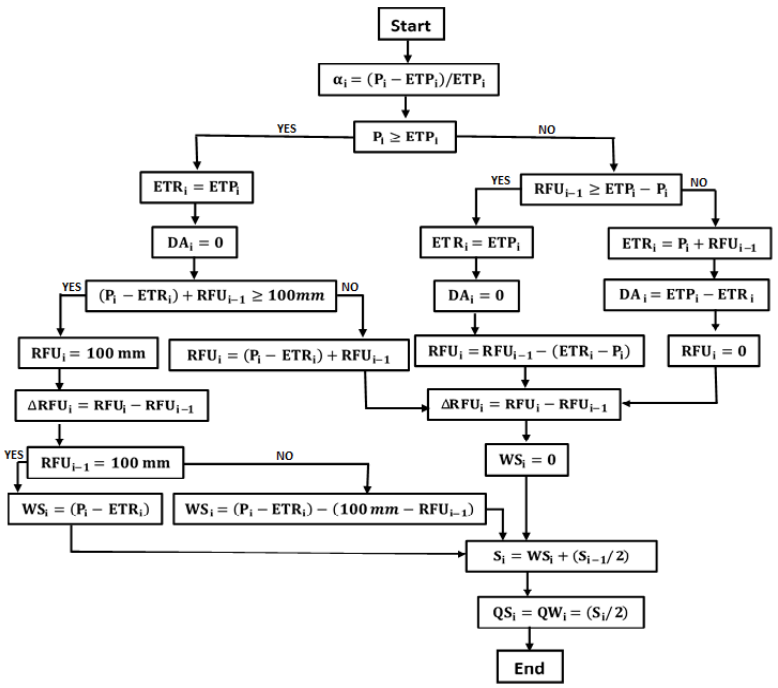
Figure 2. Flow chart for calculating the water balance according to the method of Thornthwaite [38]. P — precipitations (mm); ETP — potential evapotranspiration(mm); ETR — real evapotranspiration (mm); RFU — easily usable reserve (mm); ΔRFU — easily usable reserve variation (mm); WS — water surplus (mm); S — water layer available for total flow (mm); DA — agricultural deficit (mm).